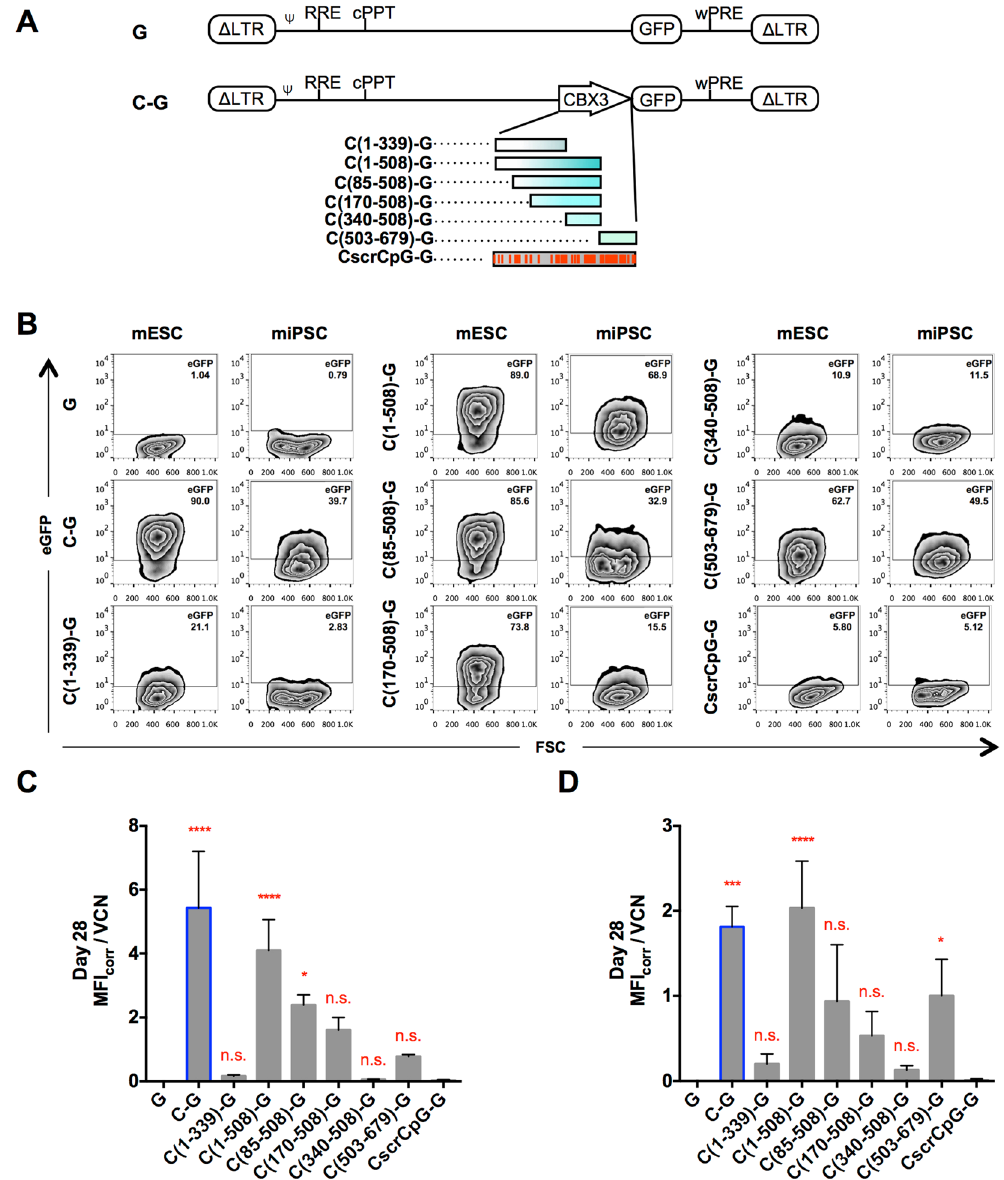
Figure 5. Promoter activity of CBX3 derived fragments. ( A ) Third generation SIN-lentiviral vectors harboring an eGFP cDNA preceded by CBX3-derived elements. ( B ) Representative flow cytometric analysis of eGFP expression in mESCs and miPSCs three days after transduction. ( C-D ) Median fluorescence intensity (MFI) of eGFP-expressing cells was measured by flow cytometry, corrected for background eGFP expression (MFI corr ; G = 0) and determined per vector copy number (VCN) in pluripotent (SSEA-1 positive) ( C ) mESCs and ( D ) miPSCs 28 days after transduction. Activity of the subfragments was compared to the eGFP negative control. Data represent independent experiments n = 3; mean ± SD; * p < 0.05, *** p < 0.001, **** p < 0.0001 as determined by one-way